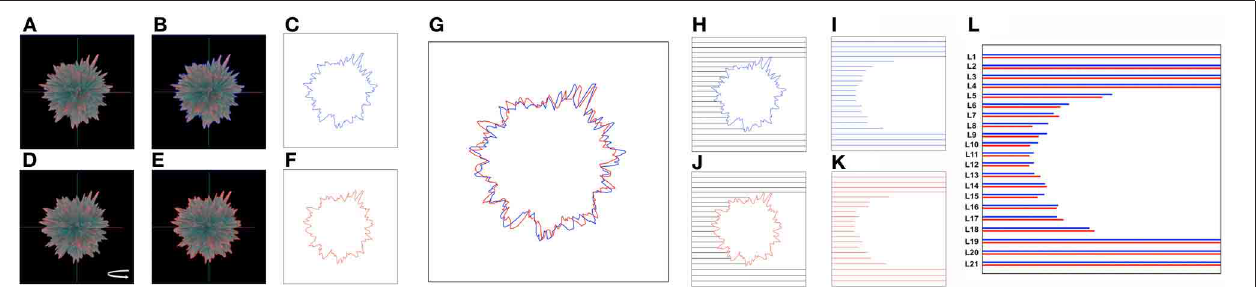
FIGURE 10 | Future developments for Plurigon feature output and analysis. Outline recognition of cryptic feature generation. As Plurigon generates a reliable-oriented three-dimensional figure it is likely that surface features may indeed have an impact upon the appreciable visual nature of the plurigon through obscuring other data points. Such an effect therefore generates an entirely new level of data that other applications may not due to their free-form structure or lack of three-dimensional rendering. To attempt to quantify this effect, and also create additional extractable data features for detailed data classification, we propose the following methodology. (A) A single exemplary plurigon is chosen and for a given set of coordinates for the axes an outline of the edge of plurigon can be generated, indicated by the presence of the blue line in panel (B) . This trace can then be extracted in (C) . With the same exemplary plurigon as in (A) , slight rotation around the vertical y axis (D) helps generate a novel